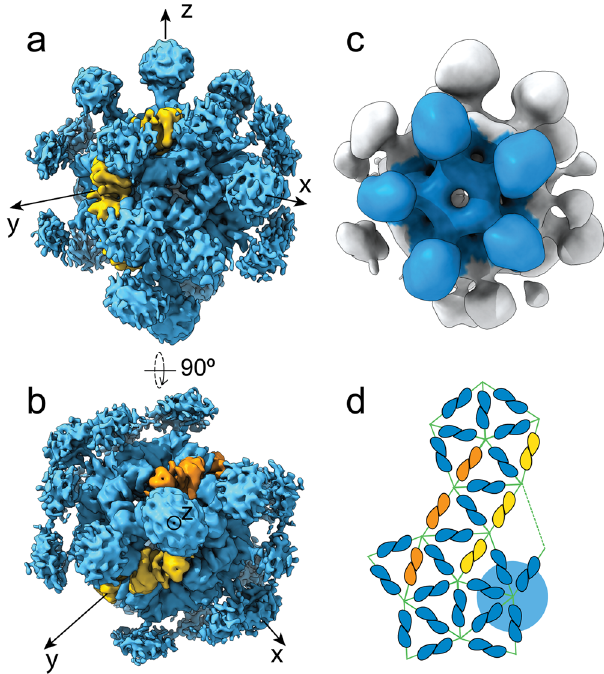
Fig. 4 Cryo-EM reconstruction of the Vibrio vulni fi cus stressosome complex ( Vv RsbR: Vv RsbS) reconstructed in D2 (a, b) and in C1 (c). a The Vv RsbR subunits are colored in blue and Vv RsbS subunits are shown in yellow and orange. b The reconstructed volume reveals an imperfect D2 symmetry. c In the volume reconstructed without applying any symmetry operators, pentameric Vv RsbR faces are observed (colored blue in c and highlighted by the blue sphere in ( d )). d The 2D representation of the icosahedron pentagonal faces reveal that only 12 hetero-triangular faces are formed in Vv RsbR: Vv RsbS, while 8 triangular faces are composed entirely of Vv RsbR.